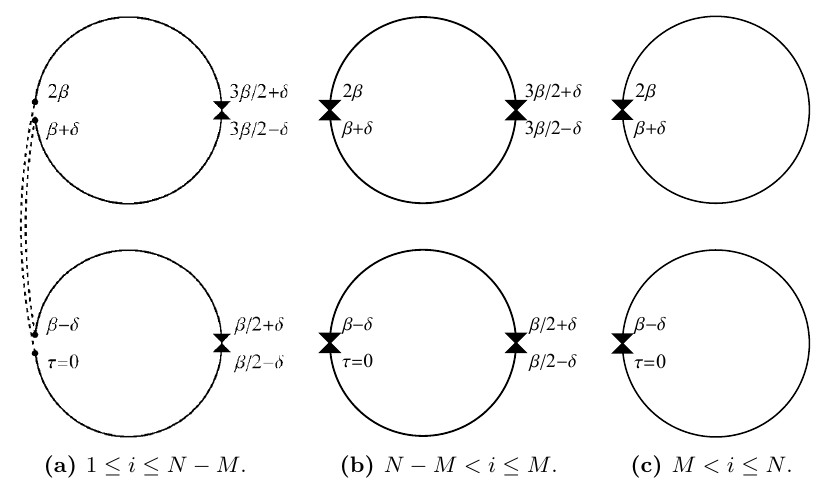
Figure 18. Imaginary time contour τ ∈ (0 , 2 β ) for the Euclidean path integral computing the nu- merator of equation (C.5) when M > N/ 2 . The twist operator inserted in the left system is indicated by the dashed line. The insertion of a measurement operator in the left and right sides is indicated by the triangles. When the projective measurement operator is inserted in the left side, the effect of the twist operator is trivial and we therefore omit the dashed line. (a) Boundary conditions (C.11) for Majorana fermions ψ i , 1 ≤ i ≤ N − M . (b) Boundary conditions (C.12) for Majorana fermions ψ i , N − M < i ≤ M . (c) Boundary conditions (C.13) for Majorana fermions ψ i , M < i ≤ N